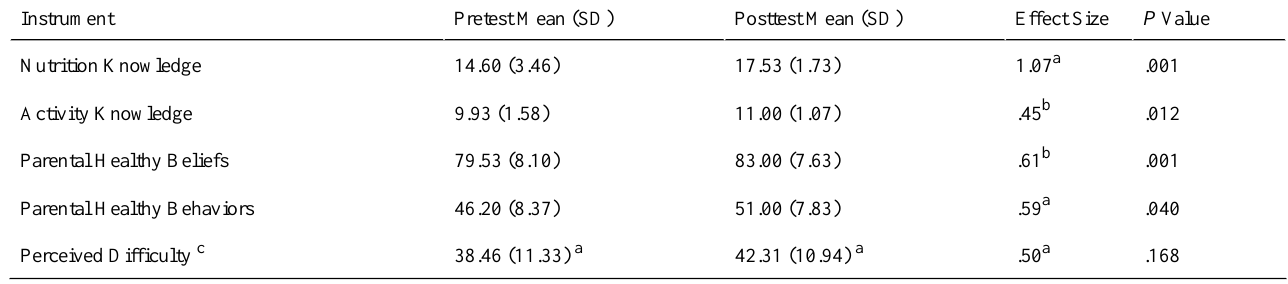
Table 5. Self-reported cognitive and behavioral outcomes for the TEXT2COPE